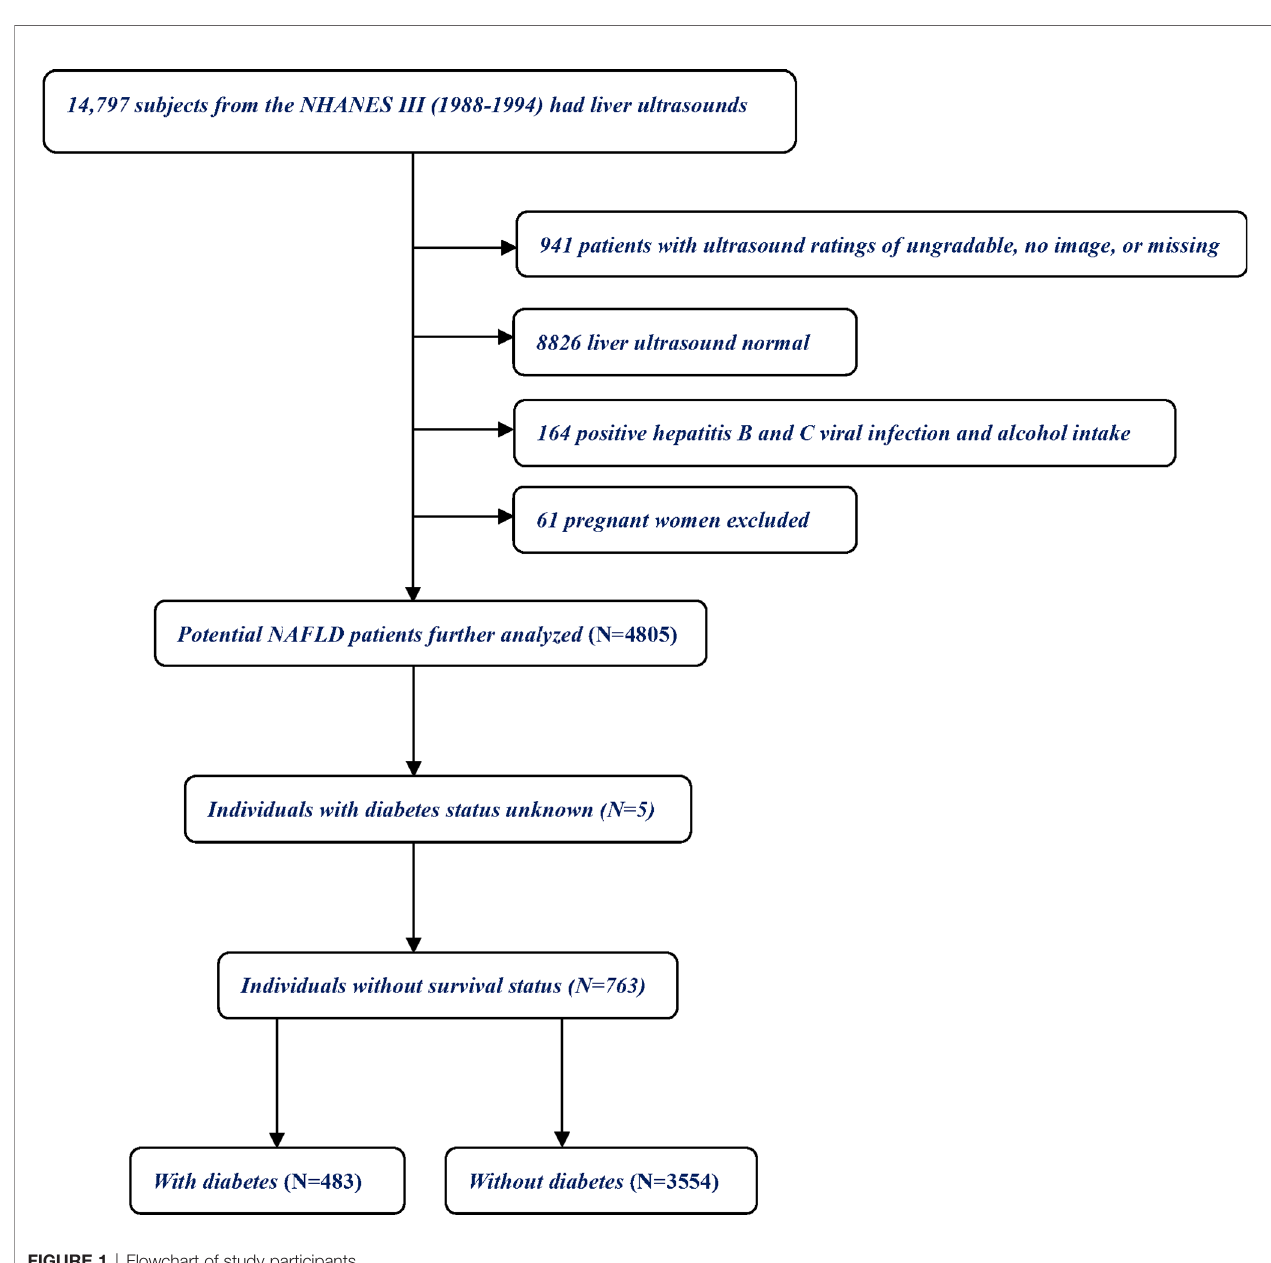
FIGURE 1 | Flowchart of study